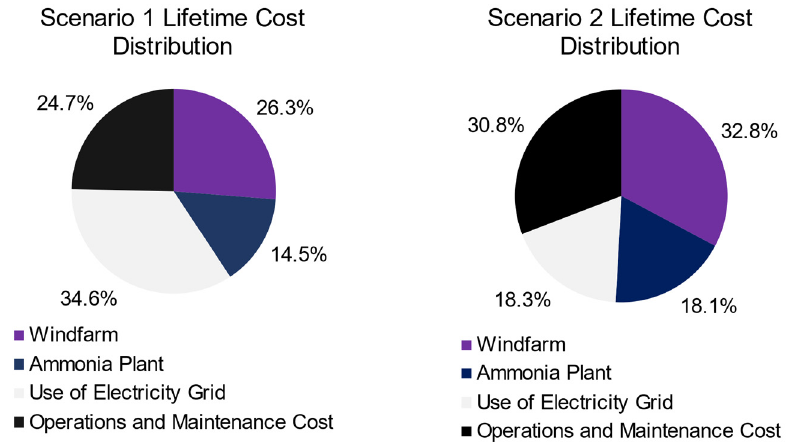
Figure 10. Lifetime expenditure distribution of the P2A System.